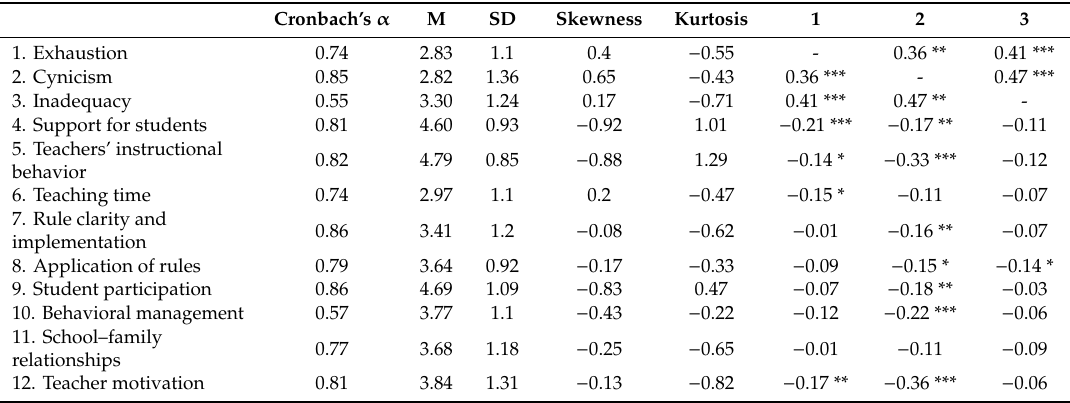
Table 1. Reliability, descriptive statistics and partial correlations of school burnout and educational practices